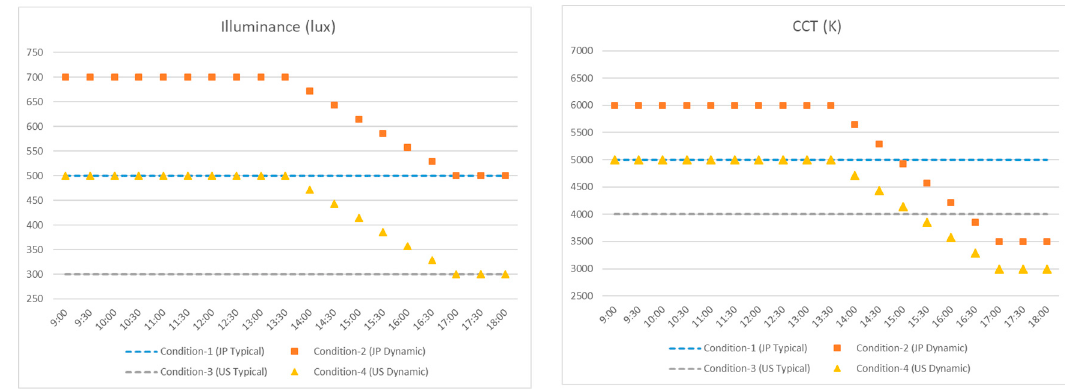
Figure 1. Lighting condition design in this study.